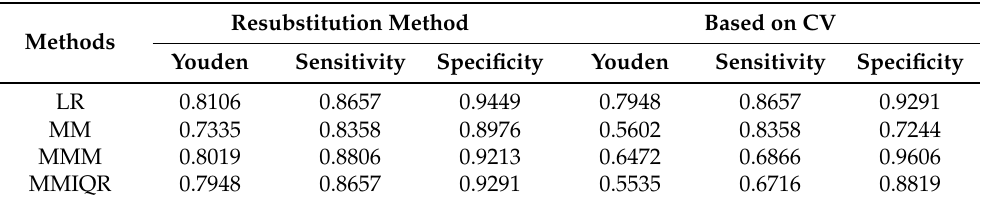
Table 5. Maximum Youden index for each method. DMD